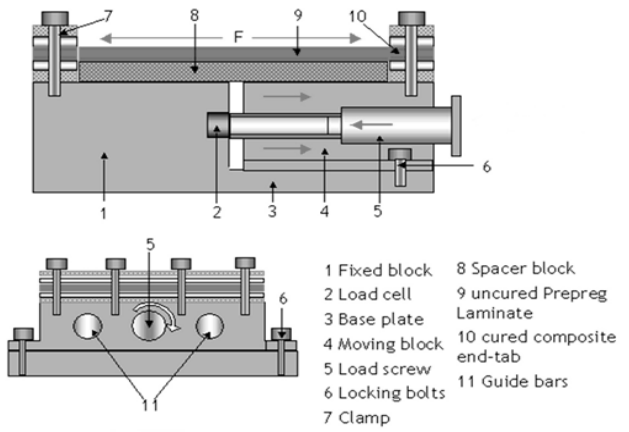
Figure 11. Schematic representation of the flatbed prestressing rig [42].